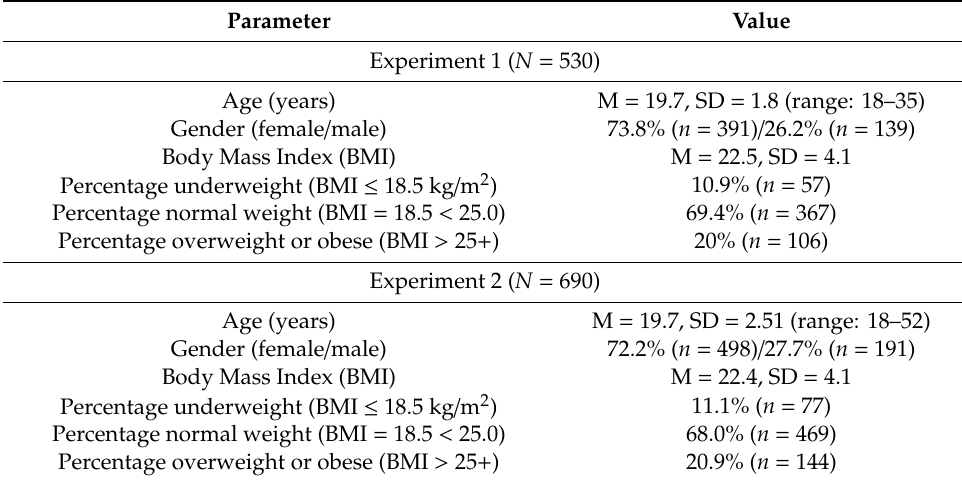
Table 1. Participant characteristics for Experiment 1 and Experiment